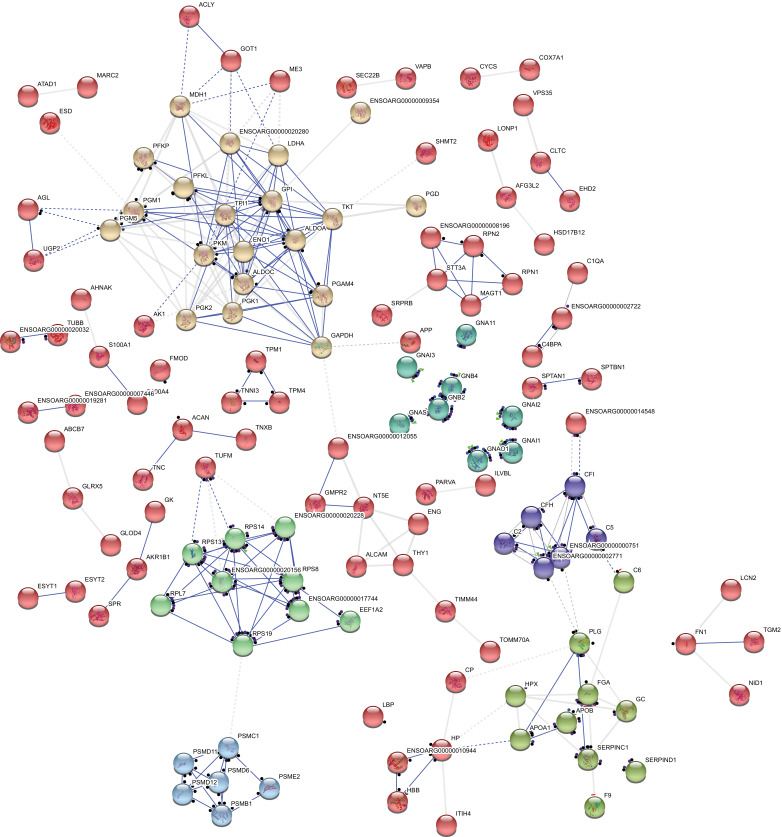
Interactome of 247 differentially expressed proteins showing clusters of shared action.Proteins are interconnected on the basis of their molecular action upon each other. Clusters (marked with the same colors) were generated based on protein functional similarities. The nodes represent individual proteins while molecular action is represented by blue (binding) or black (reaction). Dashed associations represent low confidence interactions, grey associations indicate an undetermined molecular action. Distance between nodes are automatically generated based on functions. Disconnected nodes were hidden for simplicity. From top left, rotating clockwise, the clusters are metabolic, G proteins, complement proteins, serpins, proteasome and ribosomal proteins.